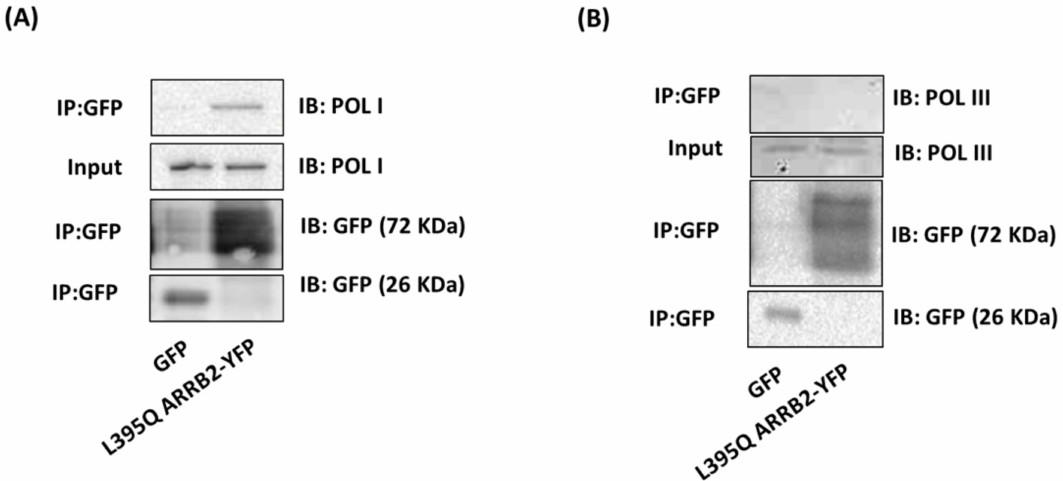
Figure 4. ARRB2 interacts with POL I but not POL III in the nucleus. ( A ) Co-immunoprecipitation analysis between POLI and L395Q-ARRB2-YFP or GFP protein complexes from transfected HEK293 cells. Western blot shows interaction between L395Q ARRB2-YFP and POL I (upper panel), input membrane immunoblotted (IB) with antibody to GFP which recognizes GFP and YFP. Molecular masses in kDa are indicated on the right. ( B ) Co-immunoprecipitation analysis between POL III and L395Q ARRB2-YFP or GFP protein complexes from transfected HEK293 cells, using a GFP antibody that recognizes YFP. Western blot shows absence of interaction between L395Q ARRB2-YFP and POL III (upper panel), input membrane immunoblotted (IB) with GFP antibody. Molecular weight in kDa is indicated on the right. Co-immunoprecipitations are representative of three independent